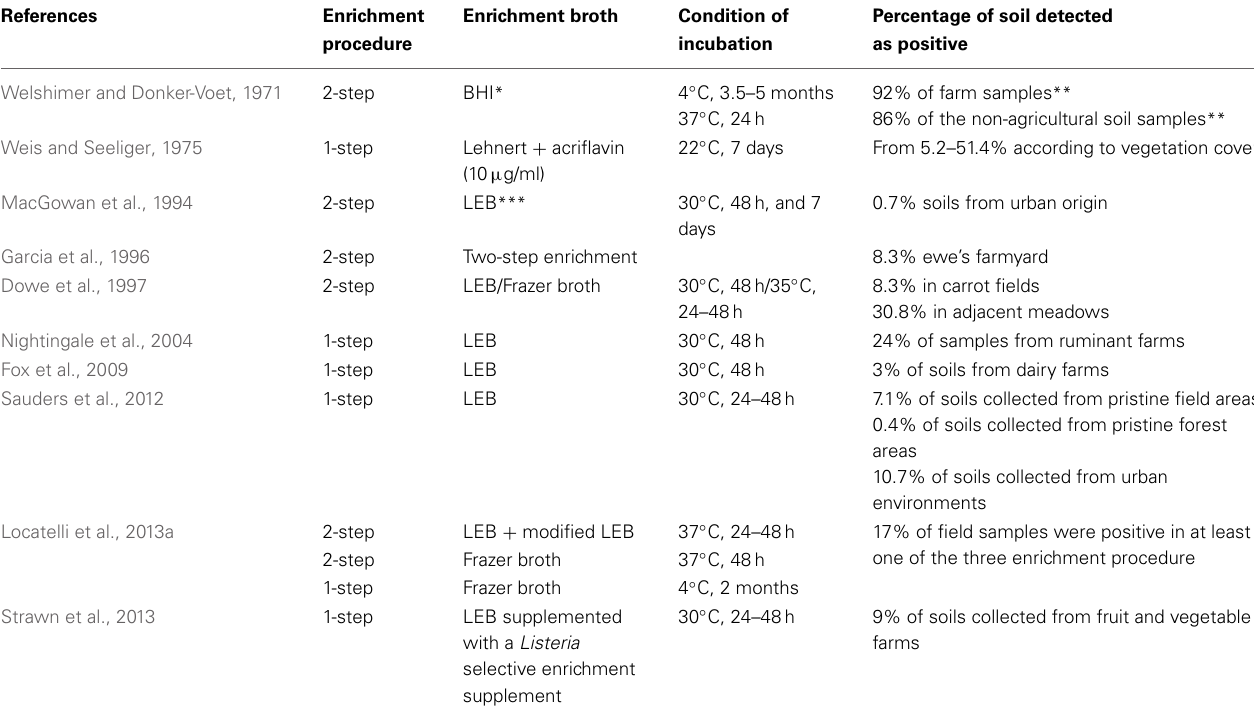
Table 1 | Listeria monocytogenes occurrence in soil and culture-based procedure used for its